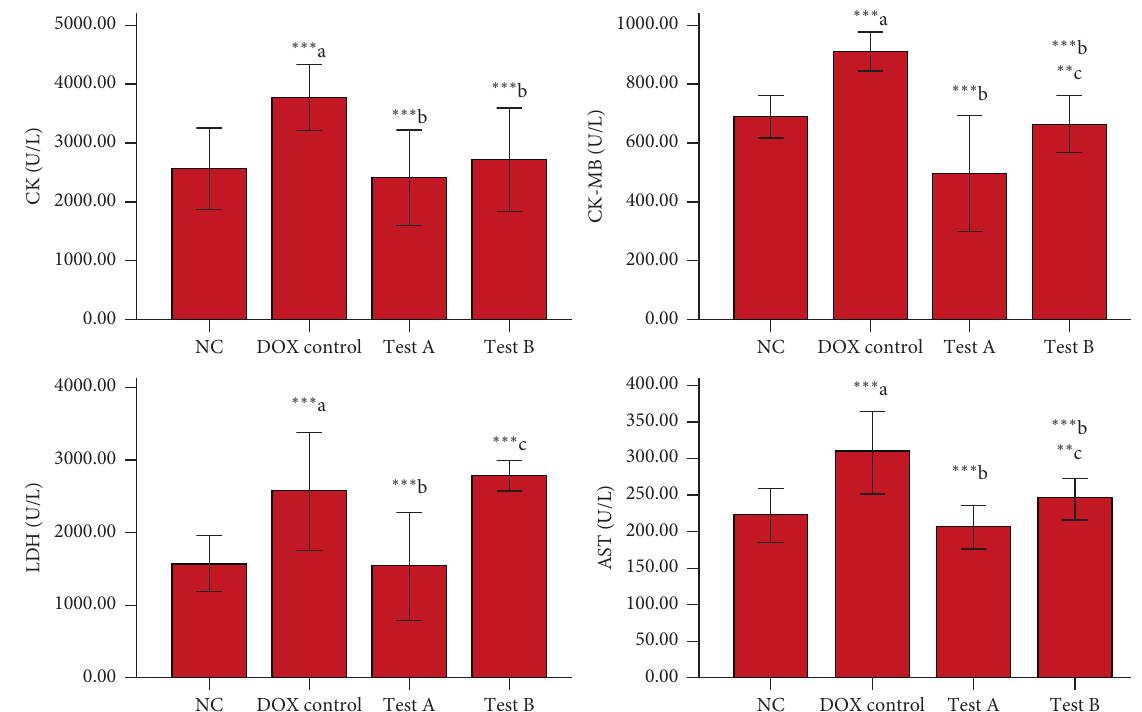
Figure 3: Effect of DOX and methyl gallate on cardiac injury biomarkers. Data were represented as mean ± SD, one-way ANOVA followed by Tukey’s post hoc test ( ∗ ∗ ∗ p ≤ 0.001, ∗ ∗ p ≤ 0.01, and ∗ p ≤ 0.05; a compared to control, b compared to DOX control, and c compared to methyl gallate 150mg/kg), NC:normal control, test- A: methyl gallate 150mg/kg, and test-B: methyl gallate 300mg/kg.